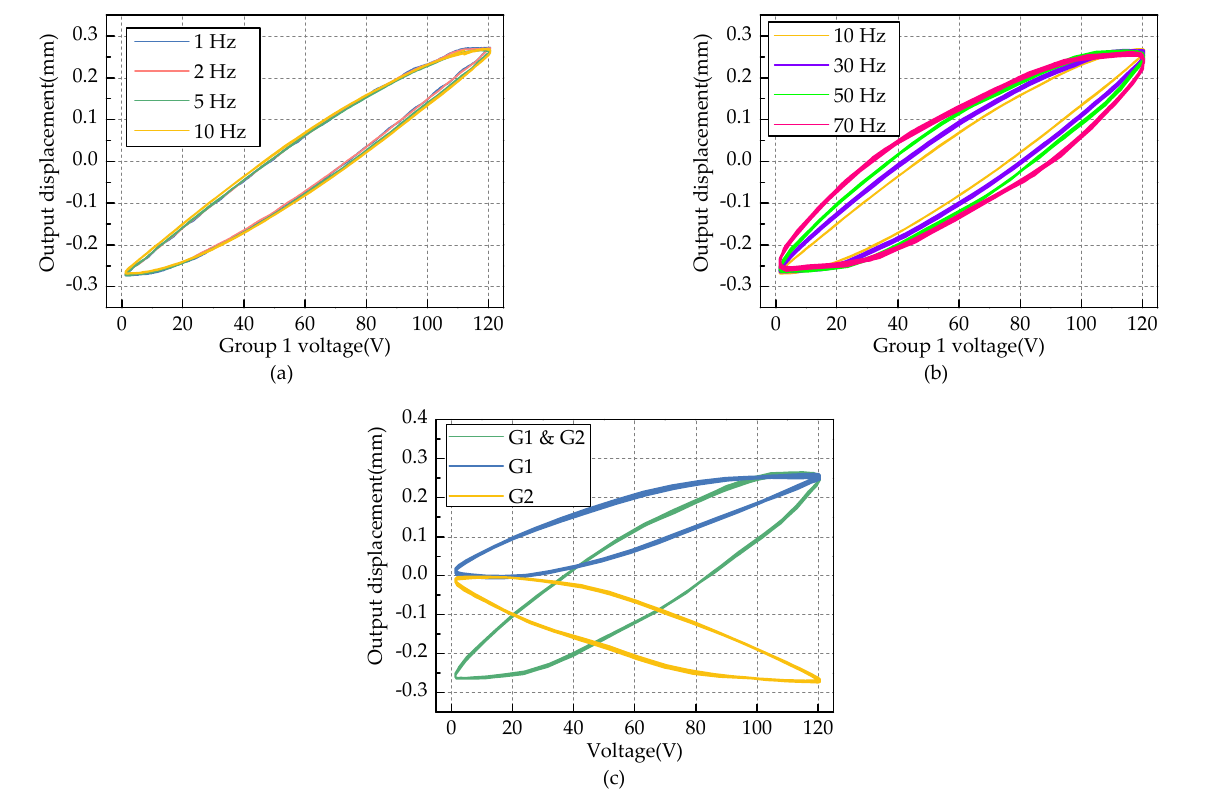
Figure 12. Output strokes of the actuator prototype in dynamic conditions: ( a ) Output displacement at low frequencies; ( b ) Output displacement at high frequencies; ( c ) Output displacement in presence of piezoelectric stack failure.